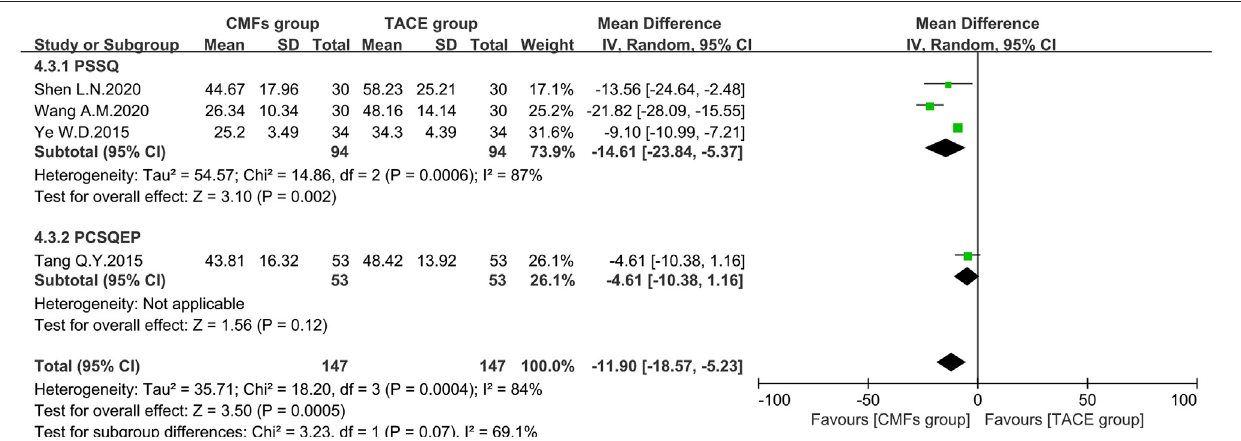
FIGURE 9 | Effect of CMFs group versus TACE group on ALT after treated with TACE for 4 weeks, including a comparison between PSSQ and PCSQEP in the subgroup.